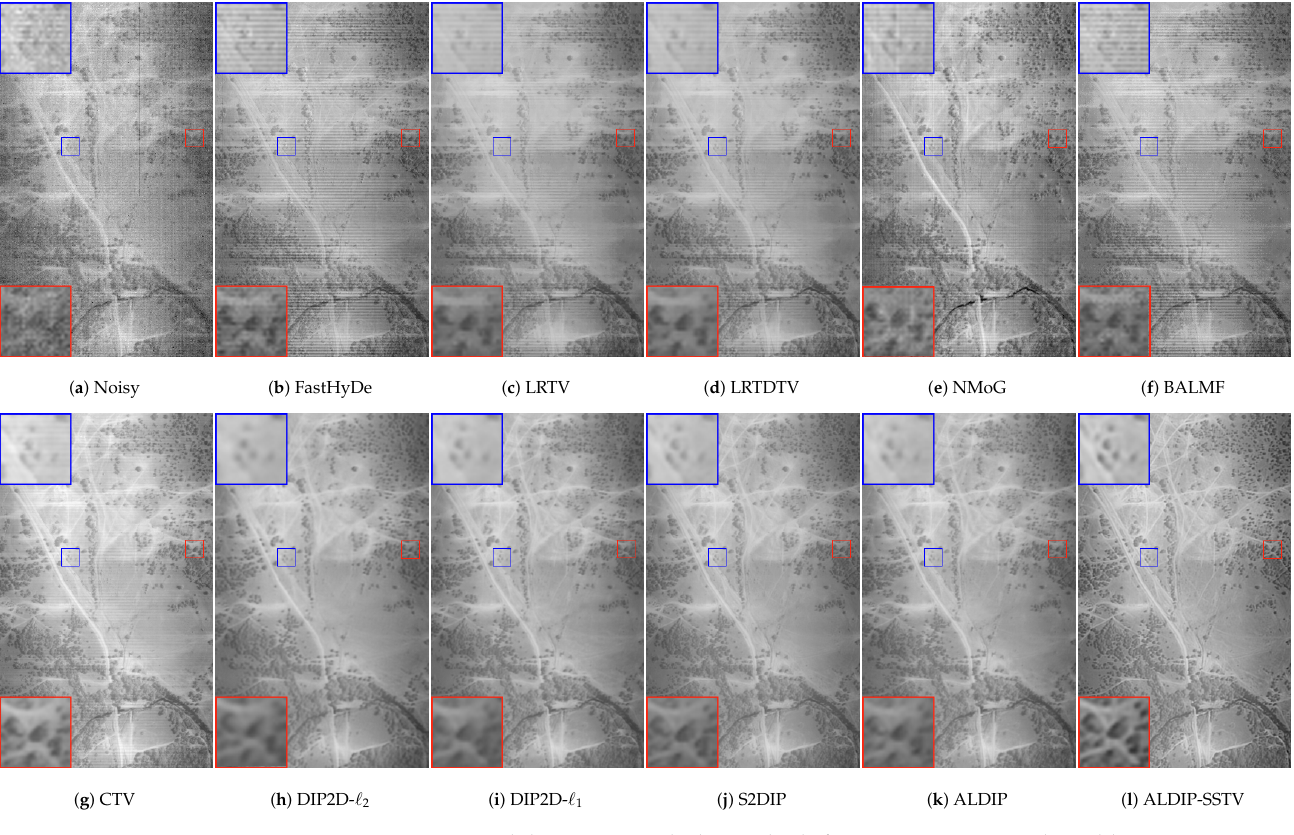
Figure 9. Noisy and denoising results by methods for comparison on real-world noisy HSI Terrain dataset. The images of band 104 are displayed. Two local areas (red and blue squares) are demarcated zoomed for easy